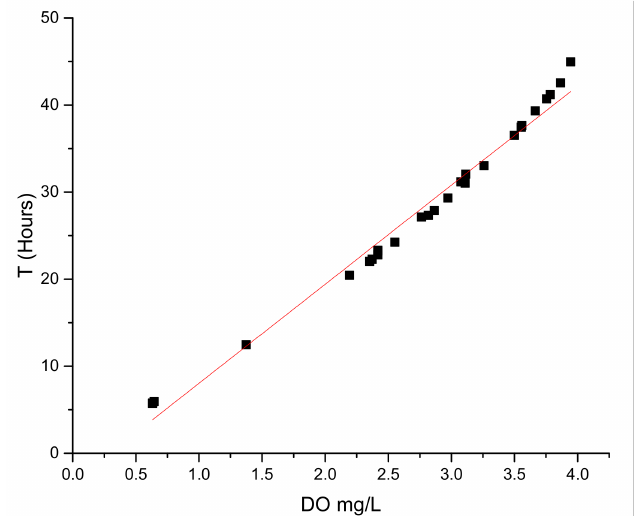
Figure 4. Linearization of respirometric kinetic.